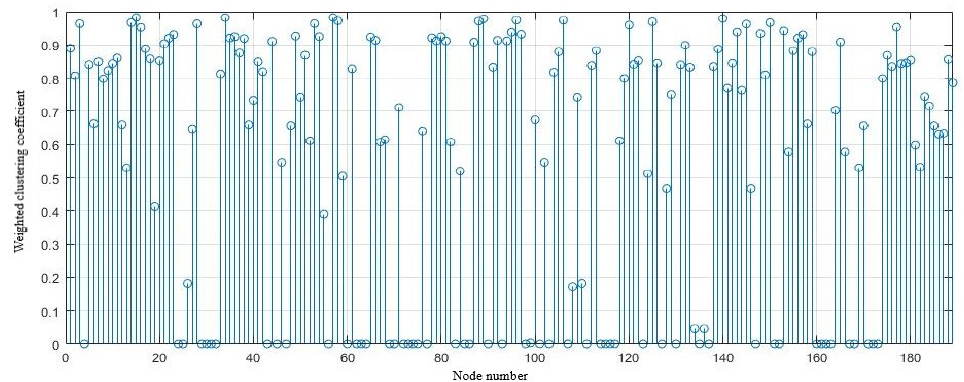
Figure 10. Weighted clustering coefficient.